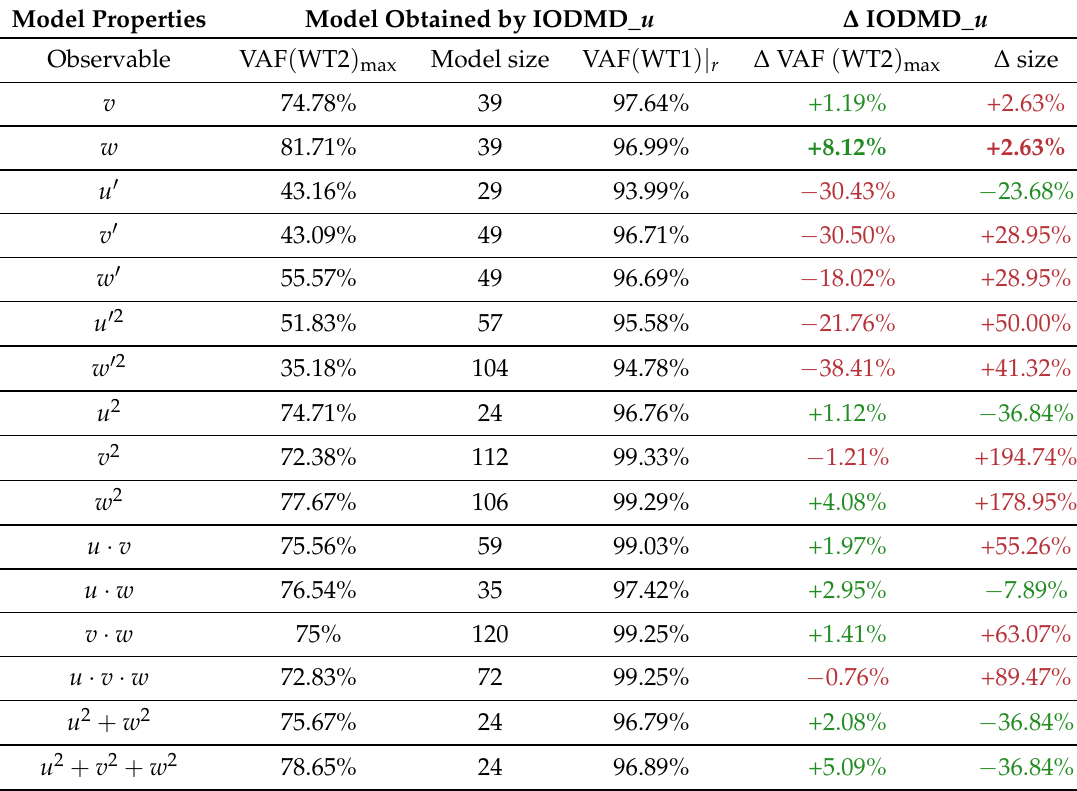
Table 3. Models validation results using the IODMD algorithm with different observables. The information in the first 4 columns is the same as in Table 1. The last two columns show the improved performance in terms of fit and the improvements in terms of the size of model. Reduced models are less computationally expensive for the purposes of model predictive control, hence they are written in green. ∆ VAF ( WT2 ) max is the difference of fit with relation to the best model obtained using IODMD u . ∆ size is the relative difference with relation to the best model obtained using IODMD u .